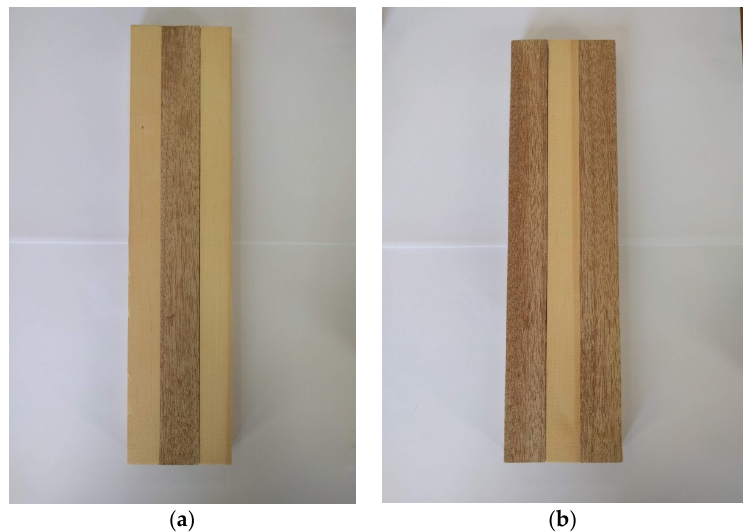
Figure 1. Types of laminated wood; fir in surface layers and meranti in core (FMF - a ) and meranti in surface layers and fir in core (MFM - b ).